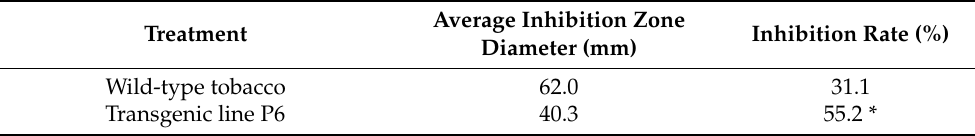
Table 1. Inhibition rate of the protein extract of transgenic and non-transgenic tobacco to V. dahliae